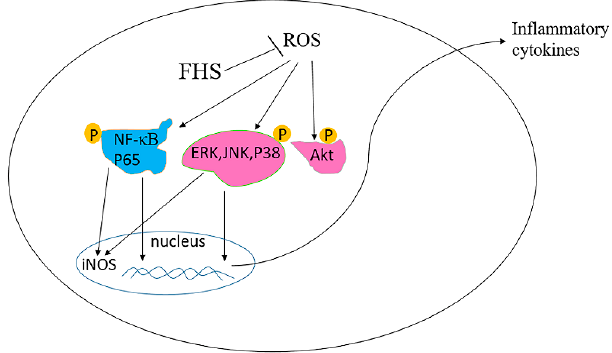
Figure 7. Proposed signaling pathways for FHS in LPS-stimulated N9 microglial cells.